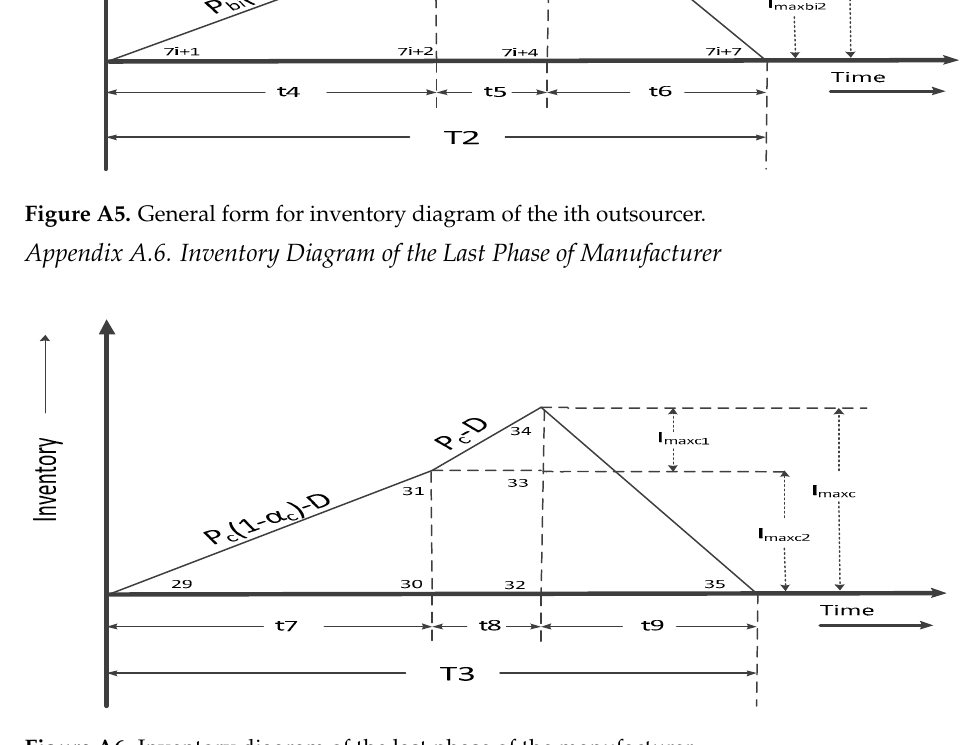
Figure A6. Inventory diagram of the last phase of the manufacturer .